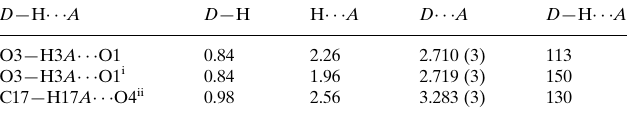
Hydrogen-bond geometry (A˚ , (cid:2)